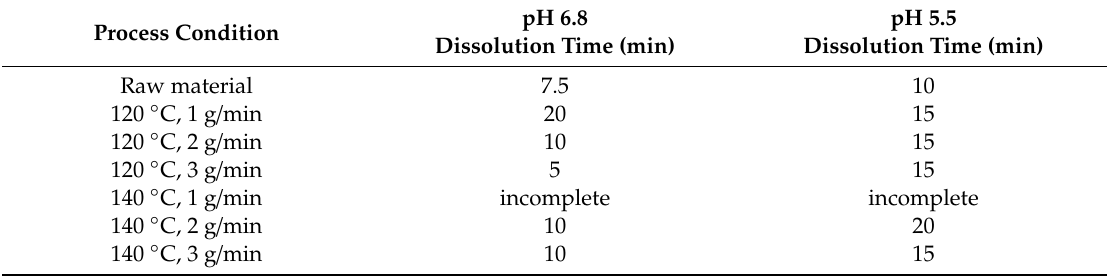
Table 2. Dissolution times of the placebo extrudates at pH 5.5 and pH 6.8,